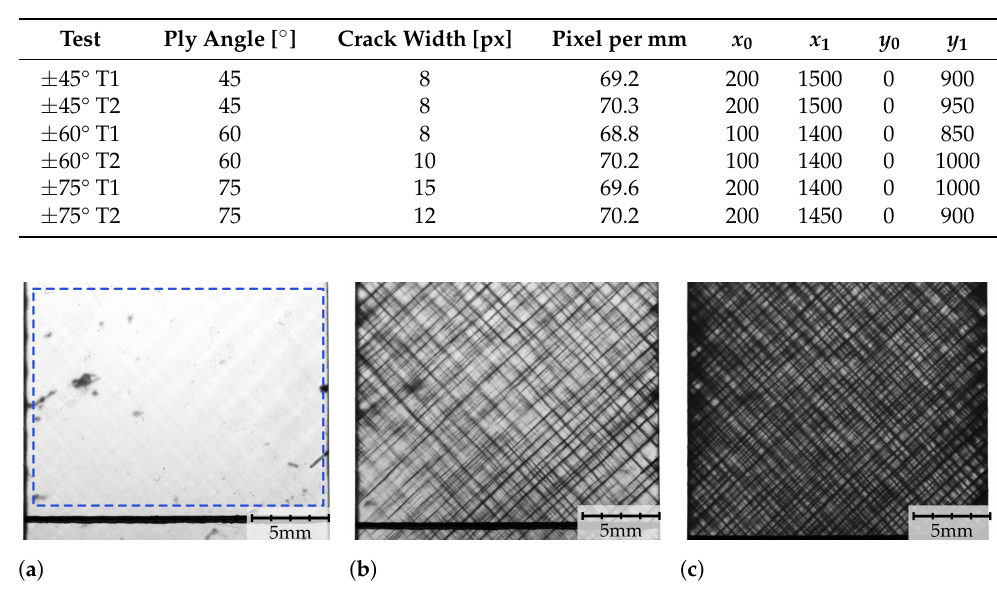
Figure 2. Example of TWLI images taken from a ± 45° specimen with a load level of 75% before the test ( a ), after 254 cycles ( b ), and and after 4013 cycles ( c ). In ( a ), the evaluation area is shown for the crack density (region of interest) marked with the blue rectangle. In ( b ), a typical crack pattern for a ± 45° is laminate shown and ( c ) shows the last image taken before failure. The shift of the specimen can easily be observed by the drift of the black line at the bottom from ( a – c ). In ( c ), delamination between the plies can be spotted as dark